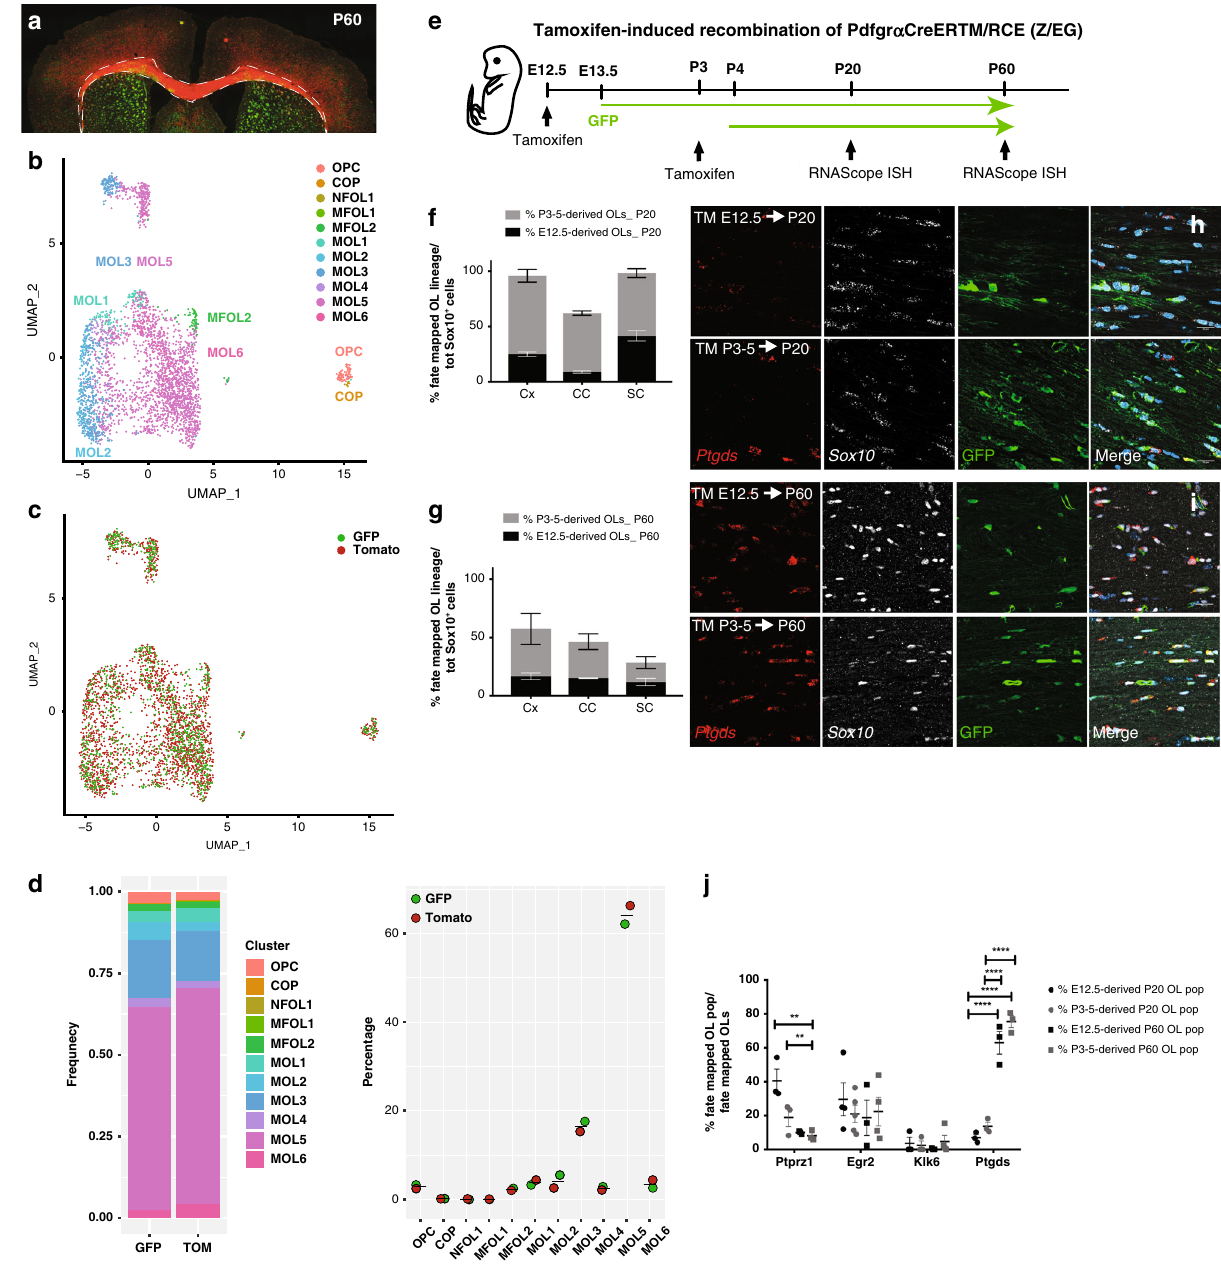
Fig. 3 The developmental origin does not specify OPCs into distinct MOL populations. a Confocal representative images of the postnatal day (P)60 brain from Emx1::Cre-SOX10::GFP-TdTom mouse. Dashed outline highlights the corpus callosum and dissected region used for scRNAseq. b , c Uniform Manifold Approximation and Projection (UMAP) plots showing the OL lineage composition determined by graph-based clustering (Seurat) 27,28 and integration cells with the Marques et al. scRNA-Seq dataset 5 ( b ) and the TdTom + and GFP + OL lineage cells contribution to the clusters ( c ). d Frequency distribution of the TdTom + and GFP + OL lineage cells forming the major clusters. n = 2853 cells. e Schematic overview of the fate mapping experimental design. Green arrows show the GFP expression timeline 24 h delayed from the time of tamoxifen injection. f , g Percentage of the fate mapped OL lineage cells (Sox10 + - GFP + cells) derived by OPCs labeled at E12.5 and P3-5 calculated on the total number of OL lineage cells (Sox10 + cells) at juvenile ( f ) and adulthood ( g ). Data are presented as mean ± SEM. n = 4 − 5 ( f ) and 3 − 5 ( g ) animals per condition, and can be assessed in the Source Data fi le. h , i Confocal representative images show the MOL5/6 ( Ptgds + -GFP + OL lineage cells differentiated from pre- (TM E12.5) or postnatal (TM P3-5) OPCs in the P20 ( h ) and P60 ( i ) corpus callosum. Scale bar = 20 μ m. j Percentages of the fate mapped OPCs-COPs ( Ptprz1 + -GFP + OL lineage cells), MOL1 ( Egr2 + - GFP + OL lineage cells), MOL2 ( Klk6 + -GFP + OL lineage cells), and MOL5/6 ( Ptgds + -GFP + OL lineage cells) populations are calculated on the total number of fate mapped OL lineage cells ( Sox10 + -GFP + cells) in the juvenile and adult corpus callosum. Data are presented as mean ± SEM. n = 3 − 5 animals per condition, and can be assessed in the Source Data fi le. Asterisks indicate a signi fi cant difference between conditions (** p ≤ 0.01, **** p ≤ 0.0001, two-way ANOVA with Sidak ’ s correction). Exact p values are reported in the Source Data fi le. TM tamoxifen, OPC oligodendrocyte progenitor cell, COP committed OPC, NFOL newly formed oligodendrocyte, MFOL myelin forming oligodendrocyte, MOL mature oligodendrocyte, TdTom tandem duplicated tomato, GFP green fl uorescent protein. Source data are provided as a Source Data fi